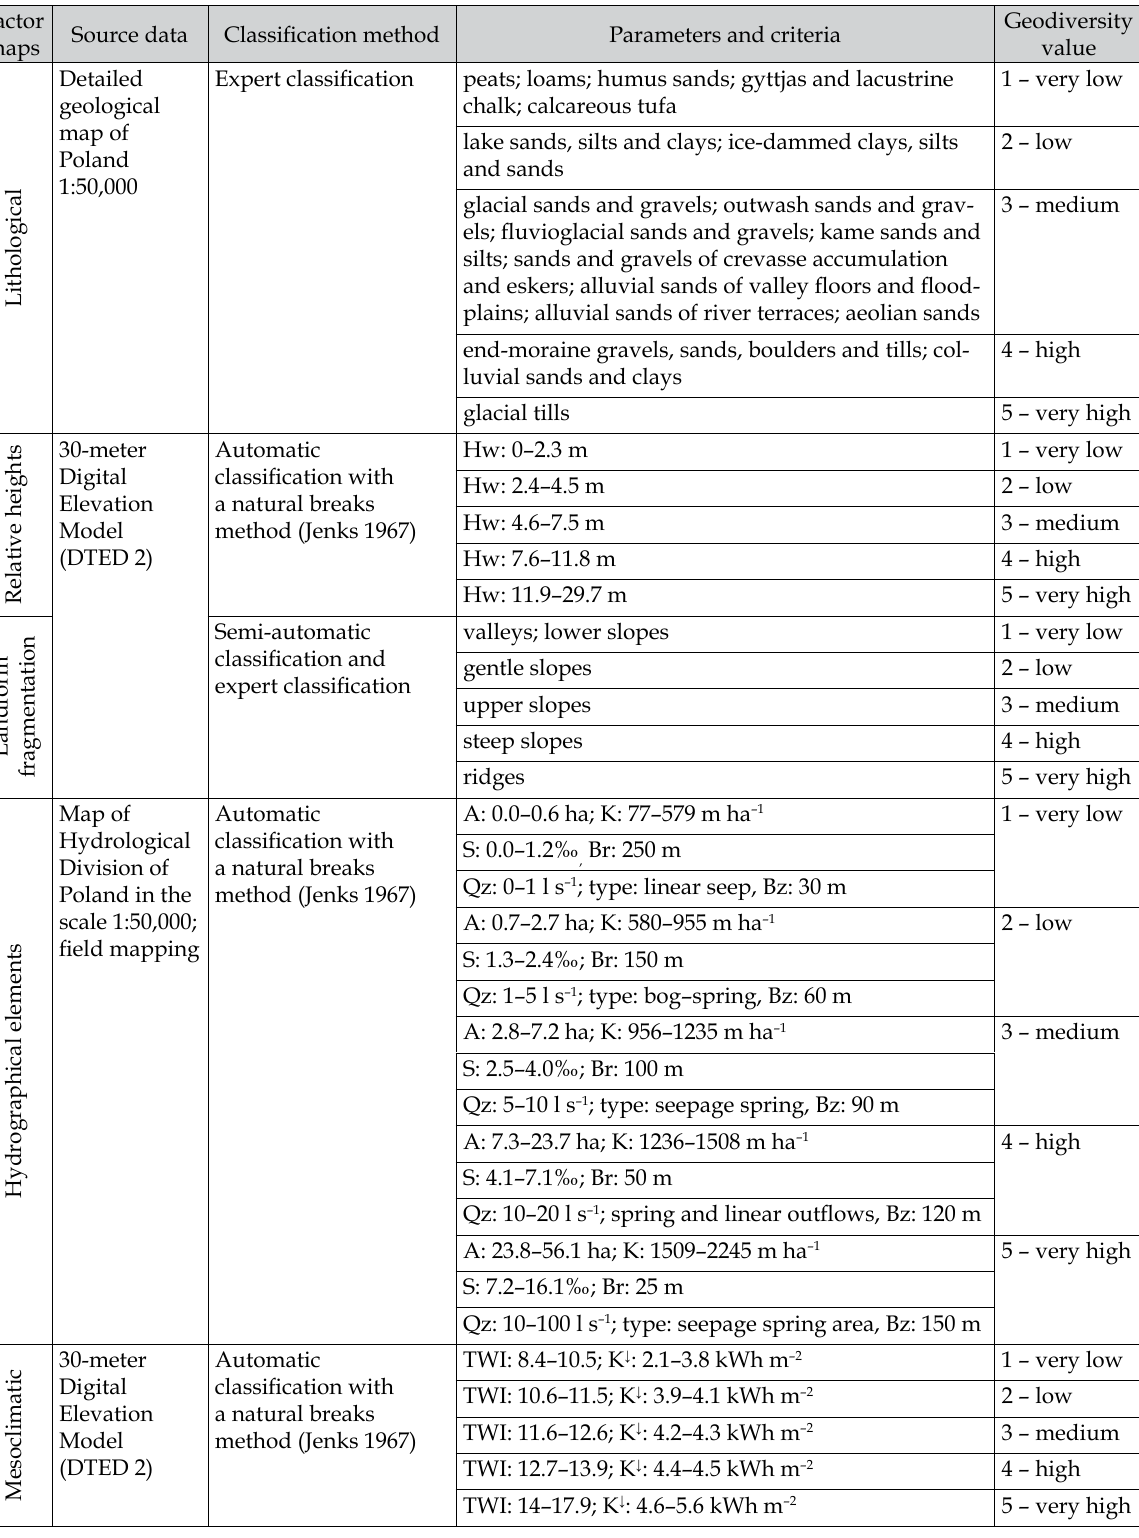
Table 1. The criteria for the assessment of geodiversity values for particular factor